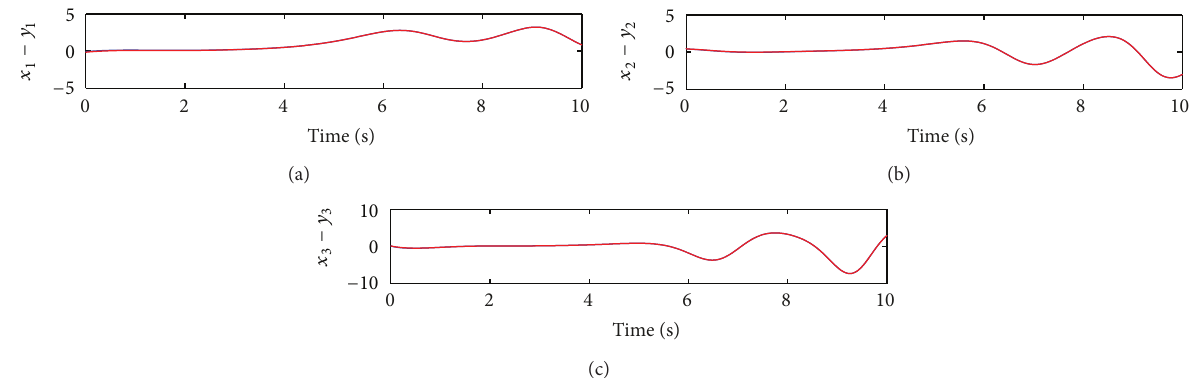
Figure 5: Synchronization of the fractional Arneodo system and the fractional Genesio-Tesi system with the control input (28) (red line represents the trajectories of the drive system, while blue line represents the trajectories of the response system). where 𝑎(𝑡) , 𝑏(𝑡) , 𝑐(𝑡) , and 𝑑(𝑡) are assumed to be unknown parameters and satisfy |𝑎(𝑡) + 6| ≤ 0.1 , |𝑏(𝑡) + 2.92| ≤ 0.1 ,